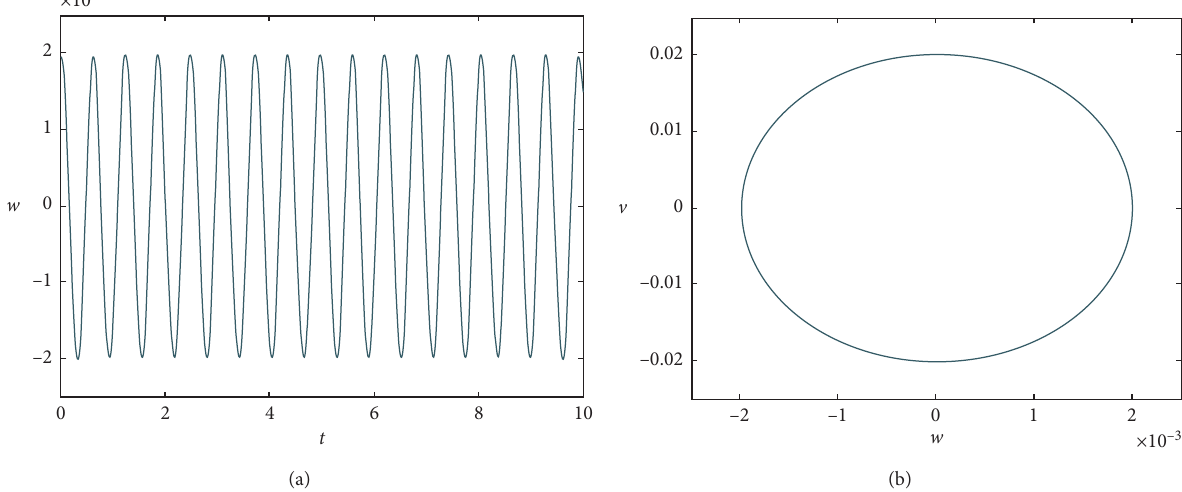
Figure 17: The system is kept in a critical state of stable and unstable when the inflow velocity U diagram of vibration amplitude on plane ( t , x